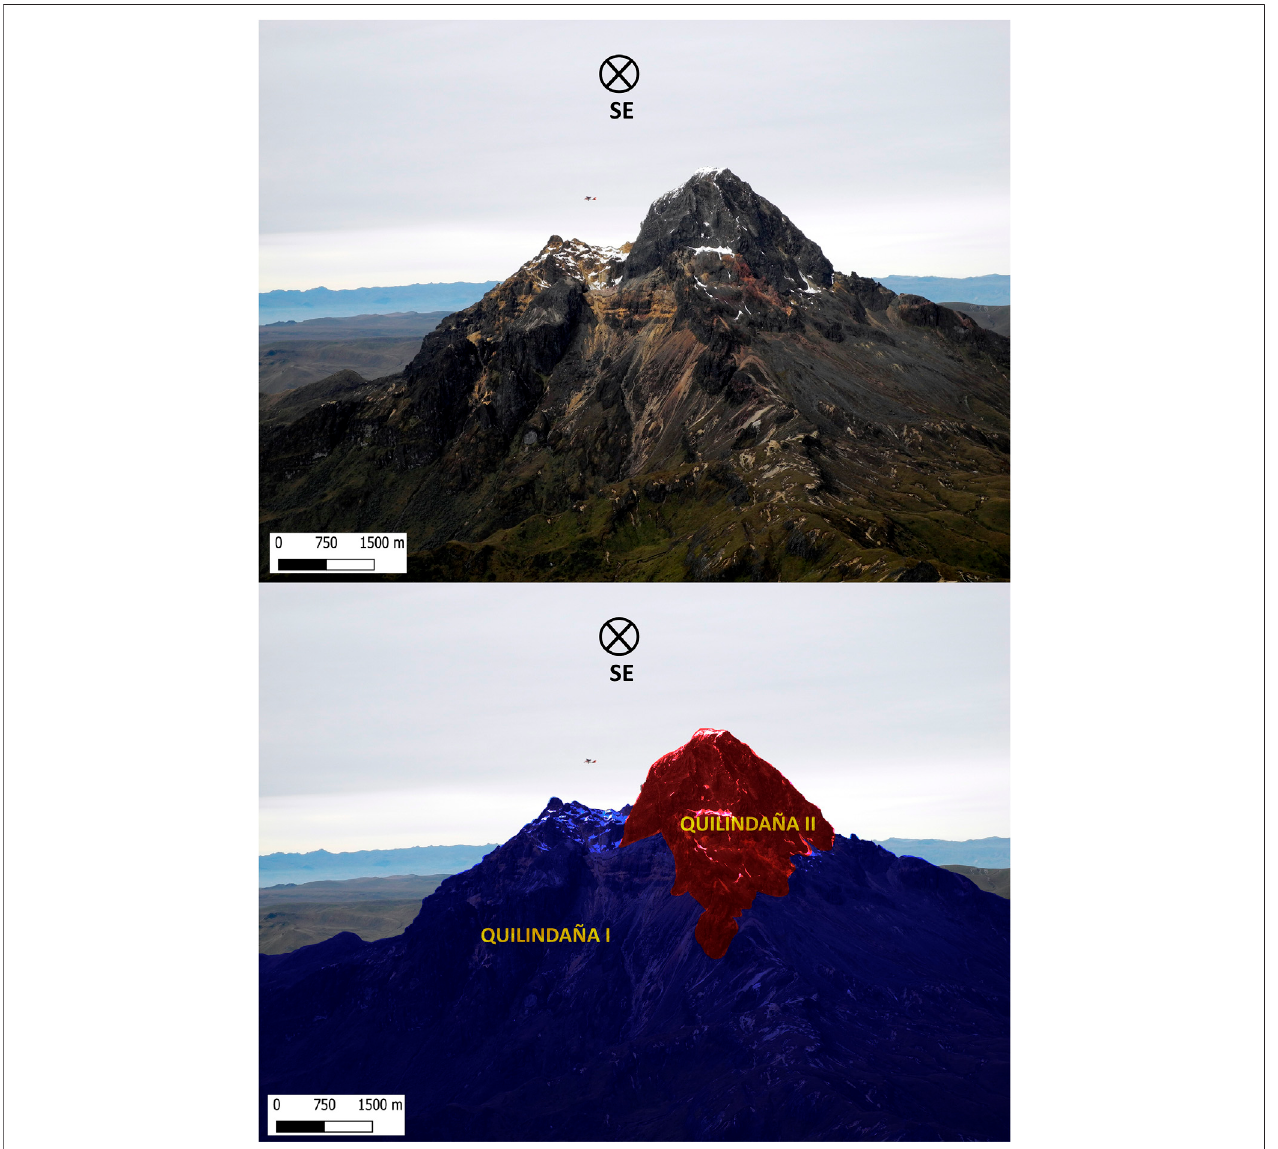
FIGURE 4 | (A) Quilindaña volcano view to the southeast. (B) Formation scheme of the two phases of Quilandaña. Ultralight plane is fl ying behind Quilindaña I.